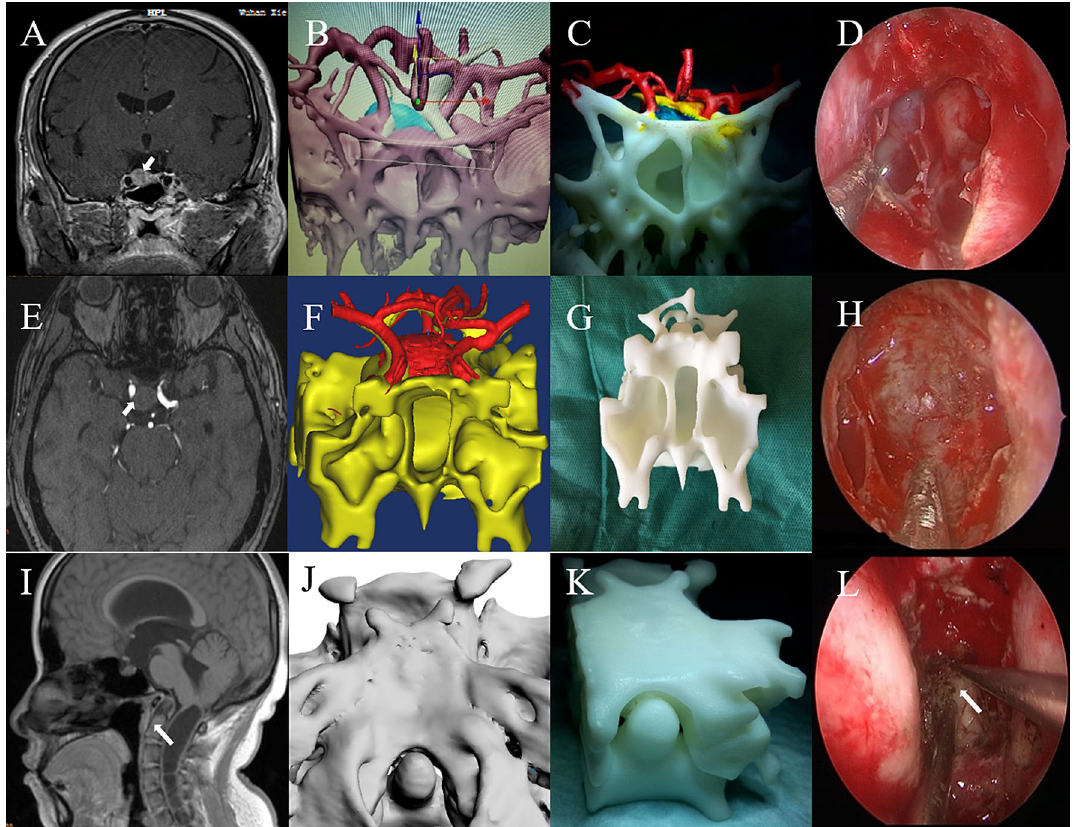
Figure 1. MRI, 3D printing data, and photographs of three patients. (A/E/I) MRI images of two patients with pituitary and one with odontoid deformity. The nidus is marked by a white arrow. (B/F/J) 3D reconstruction of each nidus in the software of MIMICS. (C/G/K) 3D printed models for each patient. (D/H/L) Intraoperative photographs of each patient.